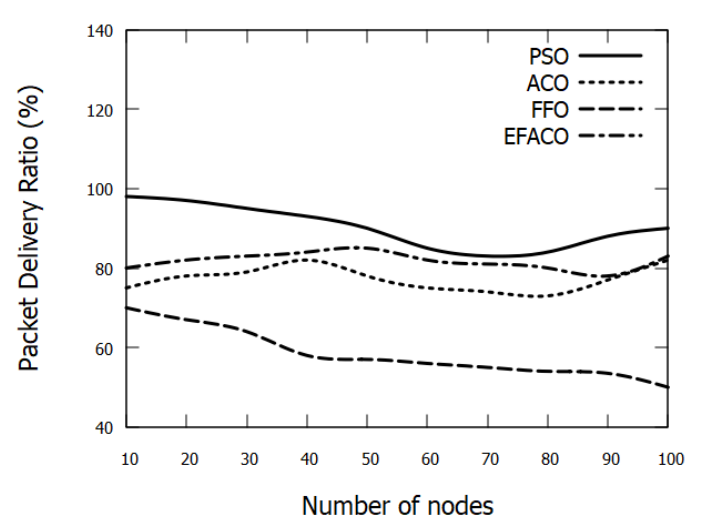
Figure 11. Comparison between proposed PSO, ACO, FFO, EFACO for Packet Delivery Ratio with a number of nodes.